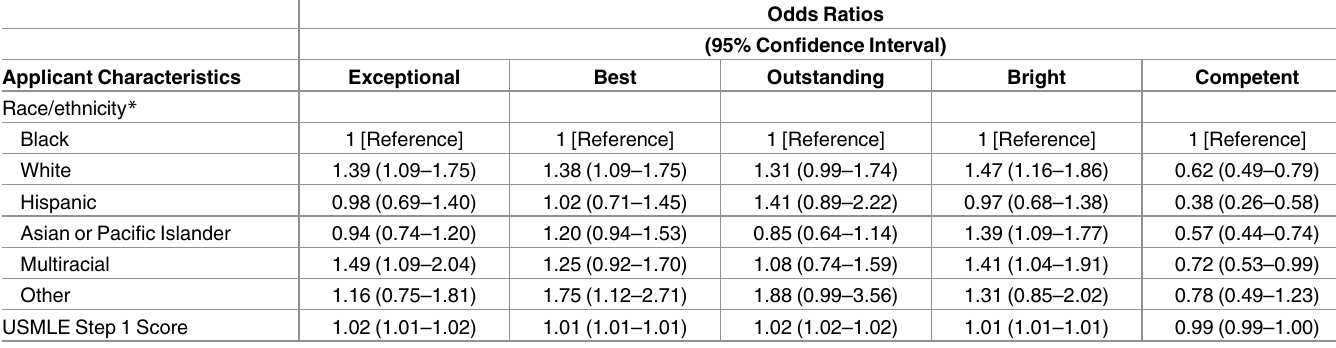
Table 5. Associations between race/ethnicity and adjective use controlling for USMLE Step 1